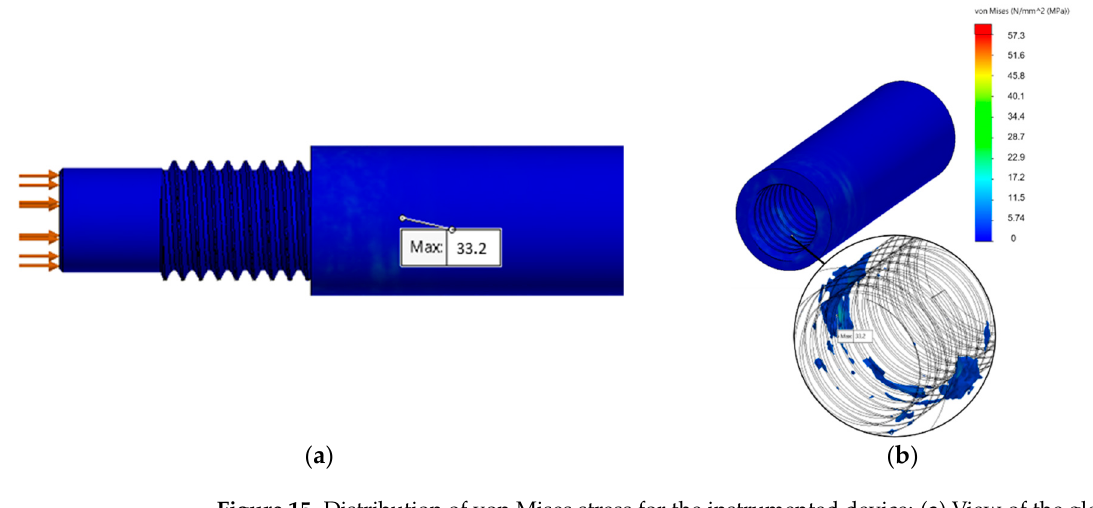
Figure 15. Distribution of von Mises stress for the instrumented device: ( a ) View of the global model; ( b ) Detail of von Mises stress distribution in the contact